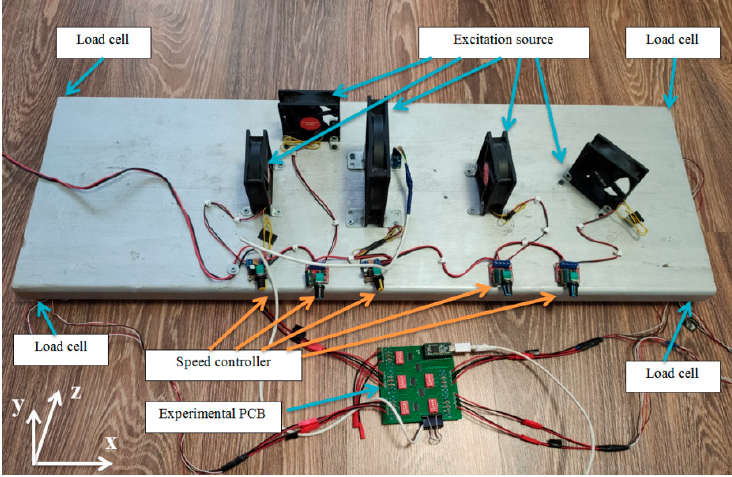
Figure 2. General view of the experimental rig.